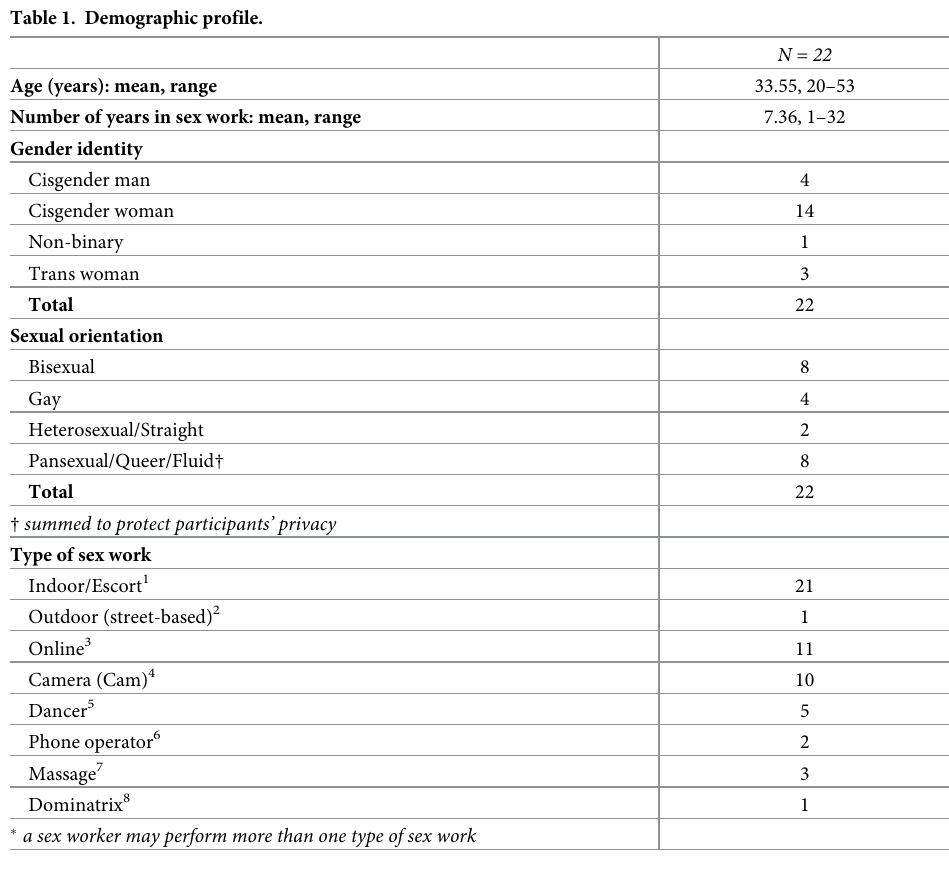
Table 1. Demographic